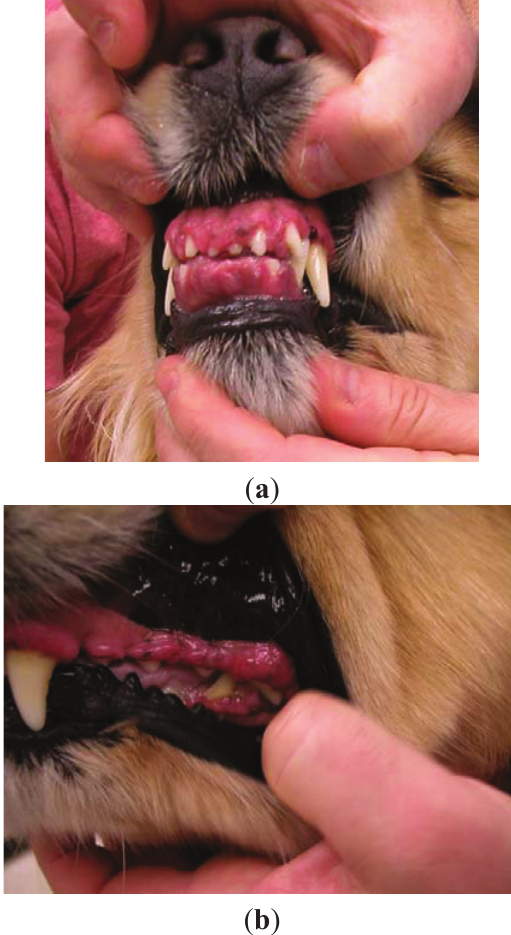
Figure 1. Case #1—Severe gingival overgrowth over the upper and lower incisors ( a ); and premolars and molars ( b ) prior to initiating azithromycin